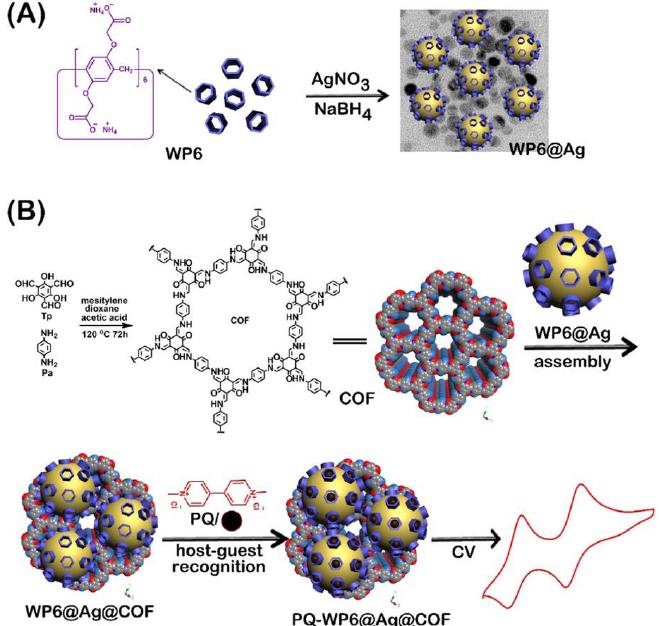
Figure 3. Schematic representation for the production of WP6@Ag ( A ); synthetic route to produce the COF and assembly of WP6-modified Ag nanoparticles on the surface of COF and its application for electrochemical sensing of PQ ( B ). Reprinted with permission from Ref. [58]. Copyright 2019 American Chemical Society.